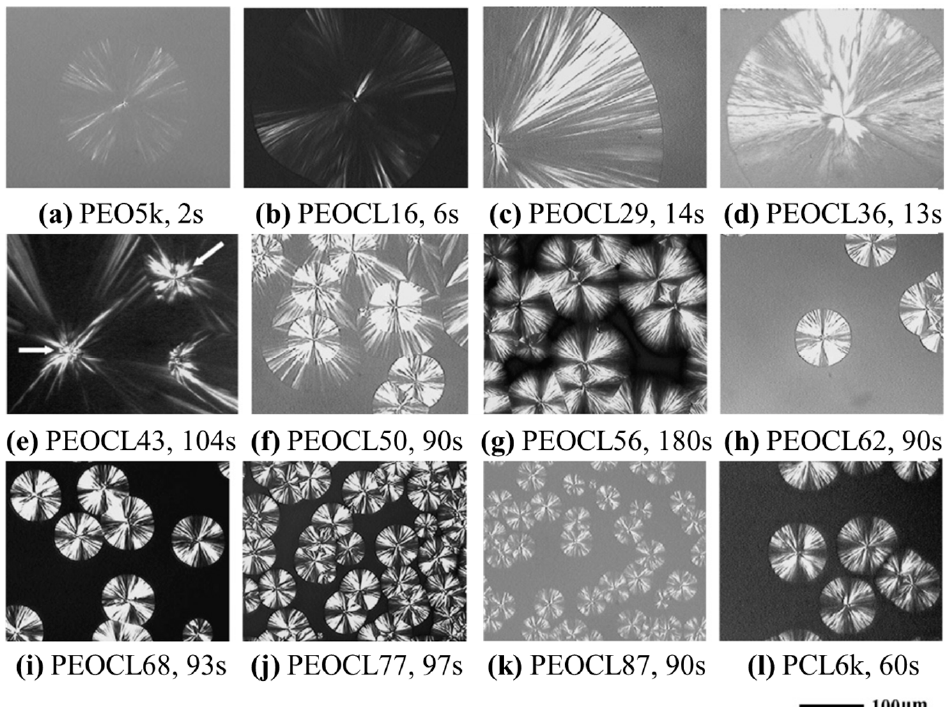
Figure 11. POM micrographs for the isothermal crystallization of PEO ( M n = 5k), PCL ( M n = 6k) homopolymers and PEO- b -PCL block copolymers with different PCL weight fractions. The samples were melted at 80 °C for 5 min and then quenched to 36 °C for the isothermal crystallization of PCL and PEO blocks. Crystallization time is shown below the graph. Block copolymers were denoted as PEOCL x , where x was the weight fraction of the PCL block in copolymer [115]. Copyright 2006. Reproduced with permission from the American Chemical Society.